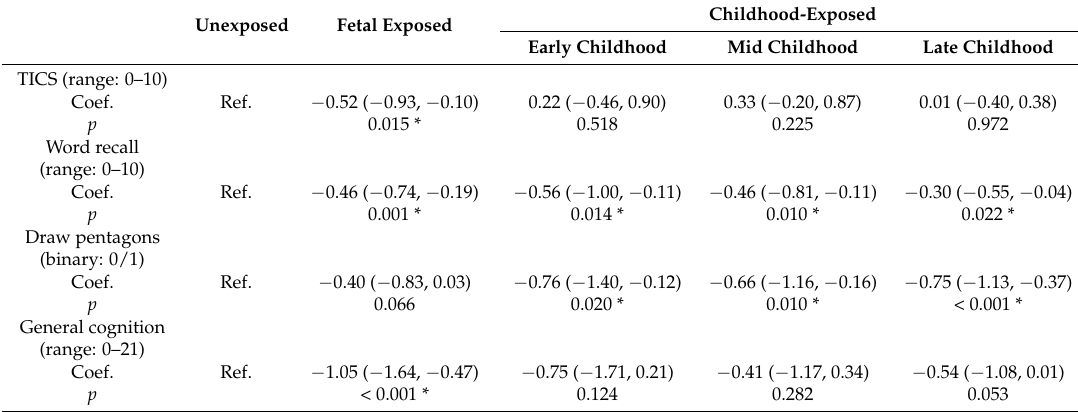
Table 3. Multiple GLM estimates the association of famine exposure with cognitive decline in 2015. Childhood-Exposed Unexposed Fetal Exposed Early Childhood Mid Childhood Late Childhood